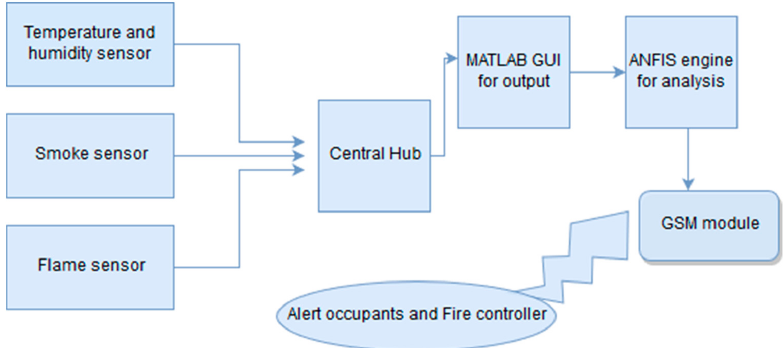
Figure 2. The architecture of the fire alarm system.